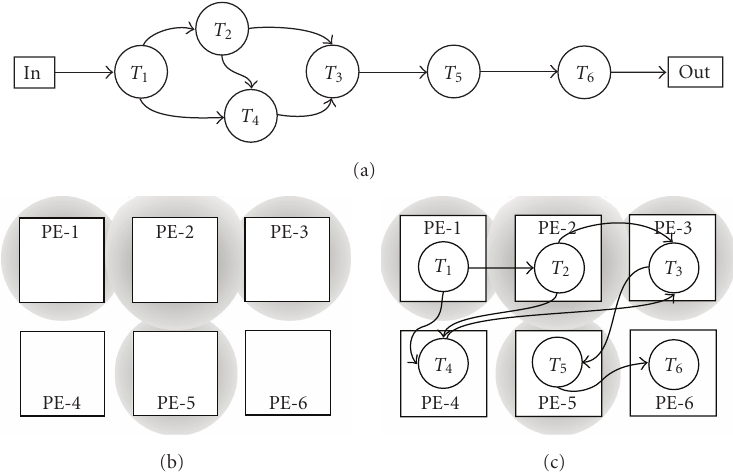
Figure 2: (a) An application example with 6 tasks: each task has to be processed at a given frequency to guarantee the synchronization between logical neighbors. (b) The MP-SoC composed of 6 PEs: the temperature of each PE is a ff ected by physical neighbors. (c) The application is mapped on the MP-SoC: applicative and physical requirements are merged on a two-metric optimization